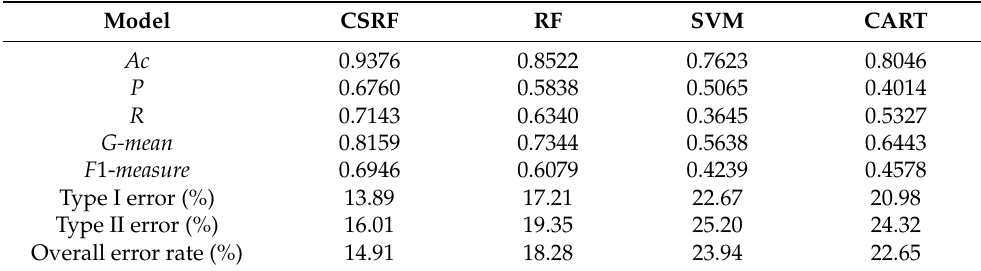
Table 6. Performance evaluation results of CSRF and several classical models. Model